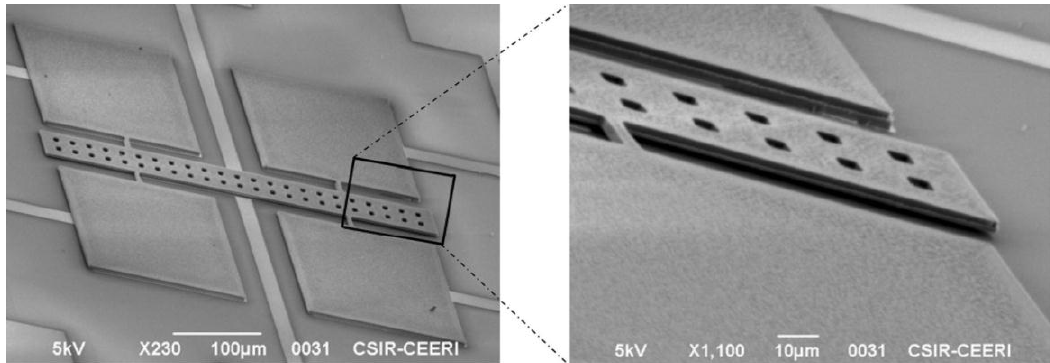
Figure 17. SEM image of a silicon xylophone supported by four beams, which take advantage of capacitive sensing to detect magnetic field [31]. Reprinted with permission from [31]. Copyright © 2016, Springer International Publishing AG.